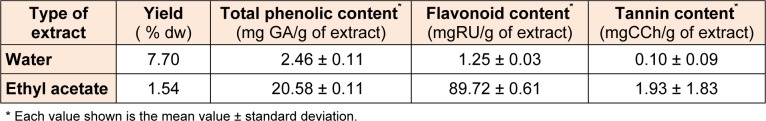
Yield, concentration of total phenolic, flavonoid and tannin content in the extracts of N. minor